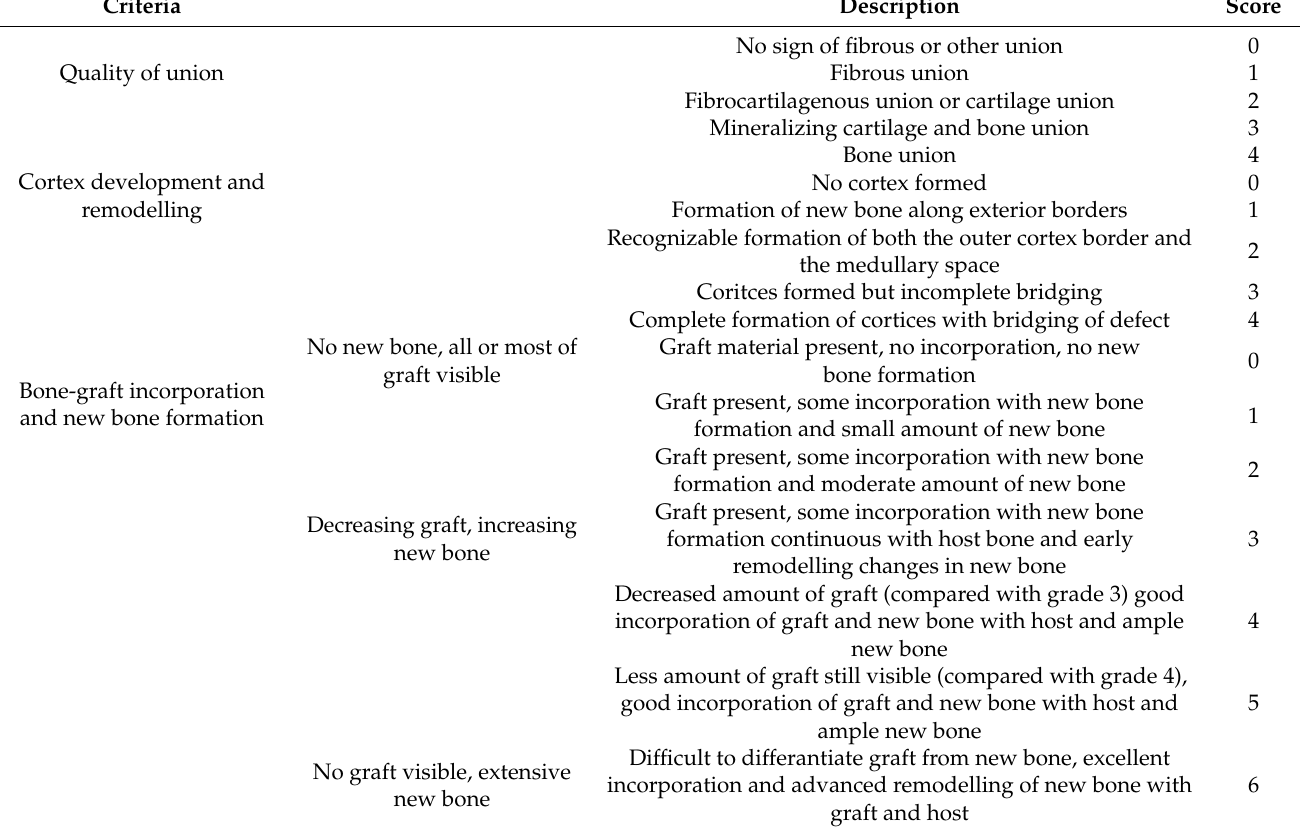
Table 2. Histological grading scale for the degree of healing (Salkeld et